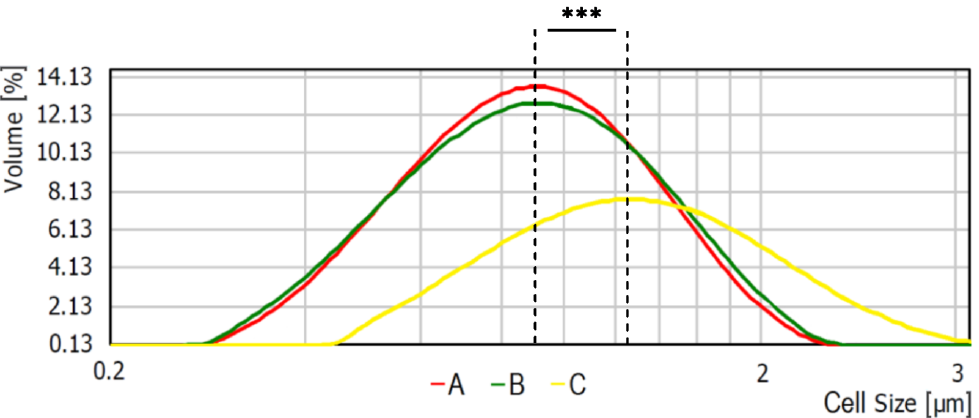
Figure 2. Average bacterial cell diameter of S. aureus Newman strain isolated from different modifications of the Mueller-Hinton agar: non-supplemented (control medium A); supplemented with 1% ( v/v ) Tween 80 (medium B); supplemented with 1% ( v/v ) Tween 80 and trans -anethole at subinhibitory concentration — MIC 50 (medium C). *** p < 0.001.